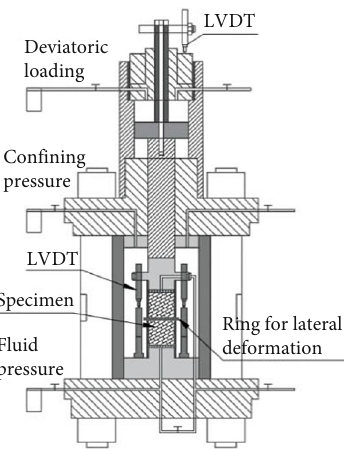
Figure 1: Device sketch of the hydro-mechanical-creep coupling triaxial system.